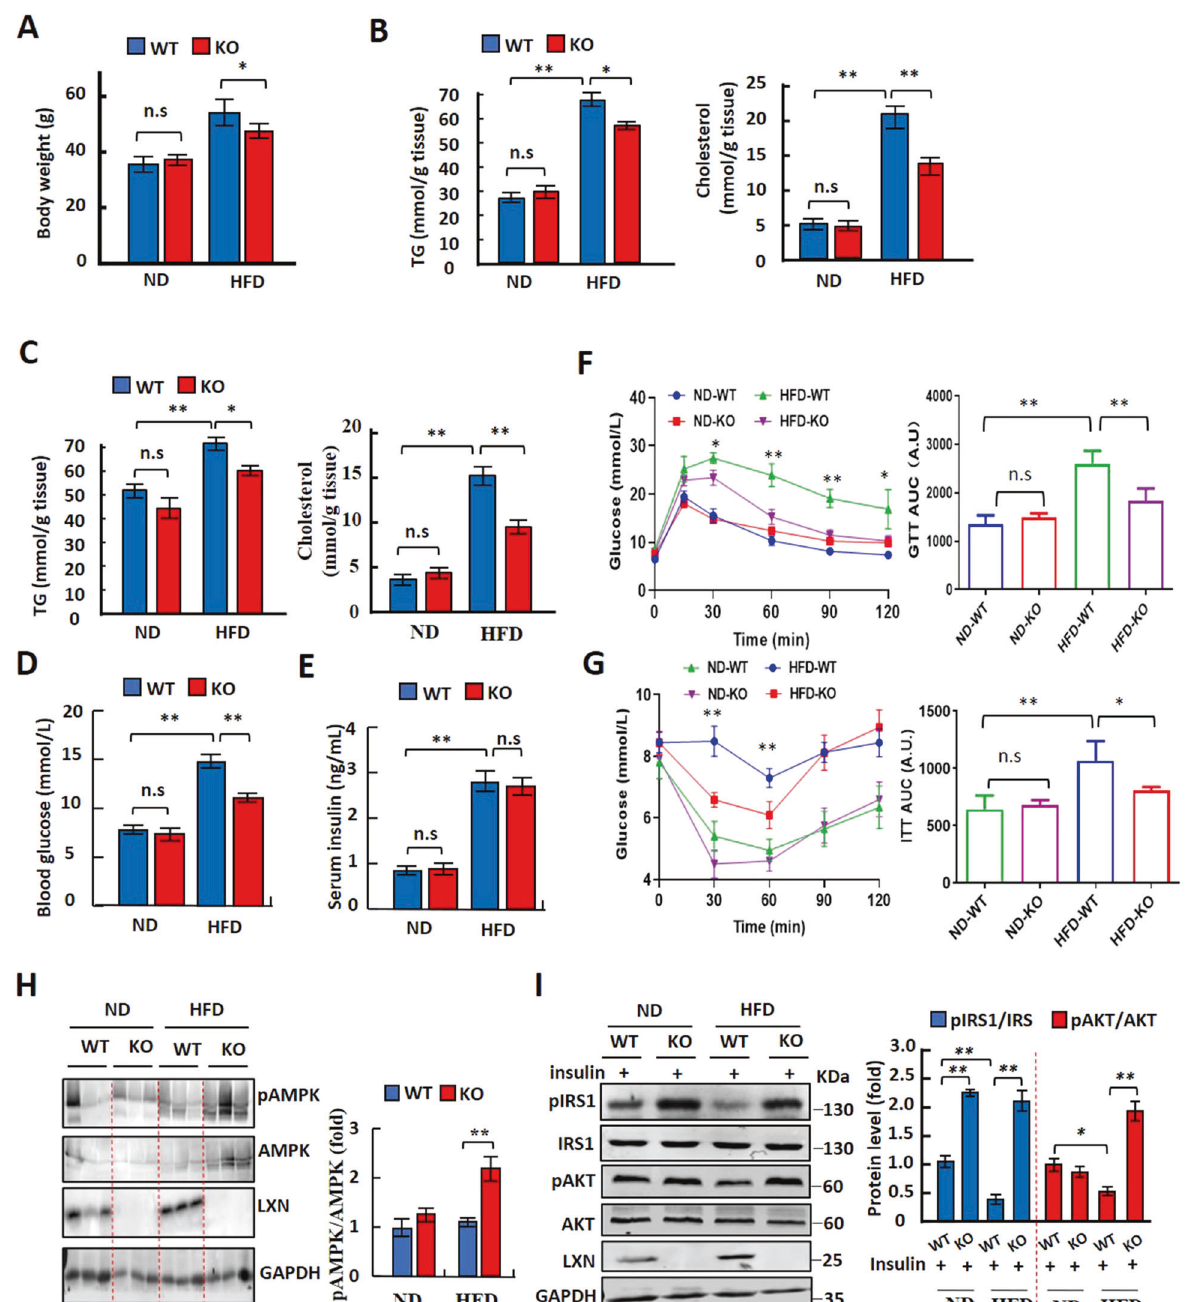
Fig. 8 LXN de fi ciency ameliorates HFD-induced insulin resistance and glucose intolerance. A Body weight in WT and LXN − / − mice fed a ND or HFD for 16 weeks ( n = 8). B , C Results for TG and cholesterol levels in perirenal adipose tissue ( B ) and sWAT ( C ) of WT and LXN -/- mice fed a ND or HFD for 16 weeks ( n = 8). D , E Analysis of fasting plasma glucose ( D ) and insulin ( E ) levels. All mice were fasted for 12 h before the analysis. F Results for intraperitoneal glucose tolerance tests (GTT) (left) and area under the curve (AUC) for the blood glucose levels (right). G Results for intraperitoneal insulin tolerance tests (ITT) (left) and AUC for the blood glucose levels (right). For the GTT, fasting overnight mice were gavage fed with a 2 mg glucose/g body wt glucose load. For the ITT, mice fasted for 6 h were intraperitoneally injected with 0.5 U insulin/ kg body wt using an insulin syringe. ND-WT, WT mice fed with ND; ND-KO, LXN − / − mice fed with ND; HF-WT, WT mice fed with HFD; HF-KO, LXN -/- mice fed with HFD. H Western blot analysis for p-AMPK, total AMPK, and LXN in the sWAT. I Western blot analysis for p-IRS1 (Ser307), total IRS1, p-AKT (Ser473), and total AKT in the sWAT. Mice were fasted overnight and injected intraperitoneally with insulin (1U/kg body wt). Tissues were excised 15 min after injection for immunoblotting analyses. All results were presented as mean ± SD, and P values were calculated with use of Student t test. * P < 0.05, and ** P < 0.01, ns: no signi fi